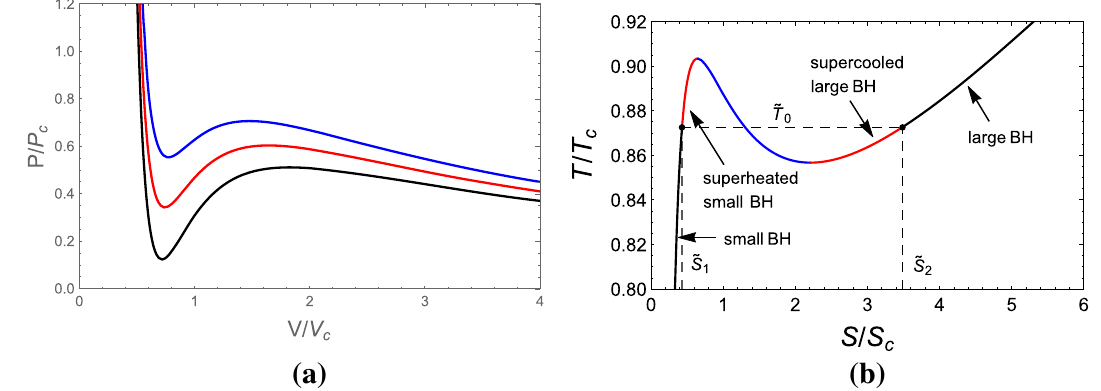
Fig. 1 a Isotherms curves with x = 0 . 3, 0, − 0 . 3 and (cid:13) T = 0 . 8 from bottom to top in reduced ( (cid:13) P , ˜ v) space. b The isobar curve in reduced ( (cid:13) T , (cid:13) S ) plane with (cid:13) P = 0 . 7 and x = 0. Black solid curves describe the small black holes and large black holes. The red curves represent